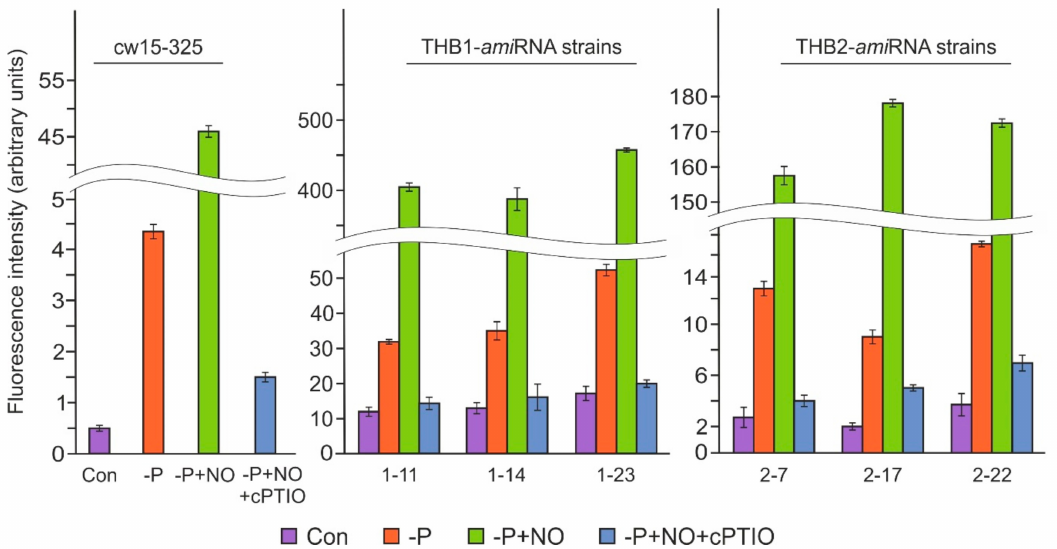
Figure 6. NO generation in THB2-ami RNA following the removal of P from the medium. A fluorescence increase was measured in the parental and THB2-under-expressing strains after a 24 h incubation in TA medium with or without 100 µ M DEA-NONOate. 300 µ M cPTIO was added 5 min before DEA-NONOate. The fluorescence intensity was measured and expressed as described in Figure 5a. Data are the means ± SE from three biological